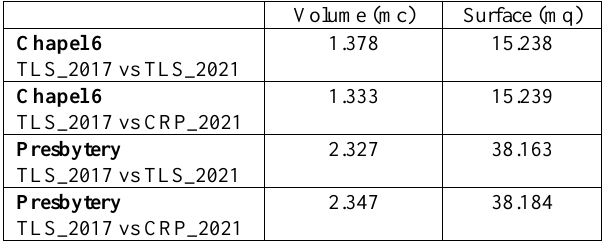
Table 3 . Comparisons between the Volume measurement from TLS and CRP point clouds